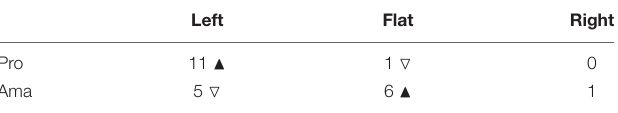
TABLE 2 | Total number of answers on slope perception for the 0.4-degree condition.